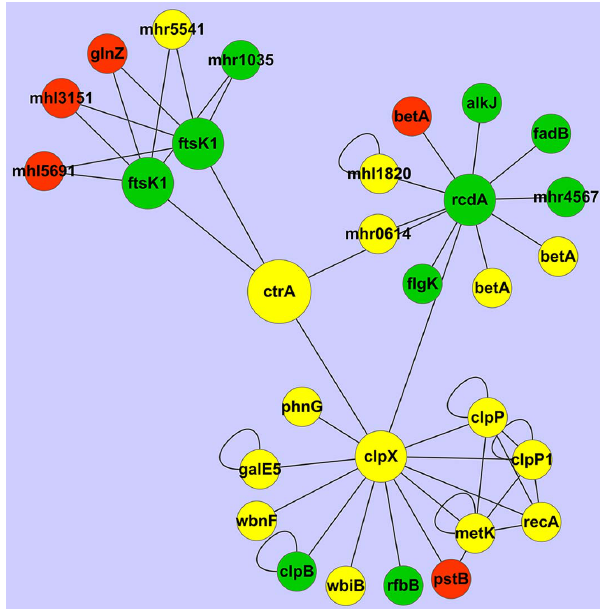
Figure 7. The subnetwork of CtrA and its interacting proteins in M.huakuii 7653R. The genes up-regulated were shown in red, those down-regulated were shown in green and those of no change were shown in Figure S1 The workflow of constructing PPI networks for M. huakuii 7653R. A: the schematic of the homologous protein-protein interactions network through the concepts of orthologous